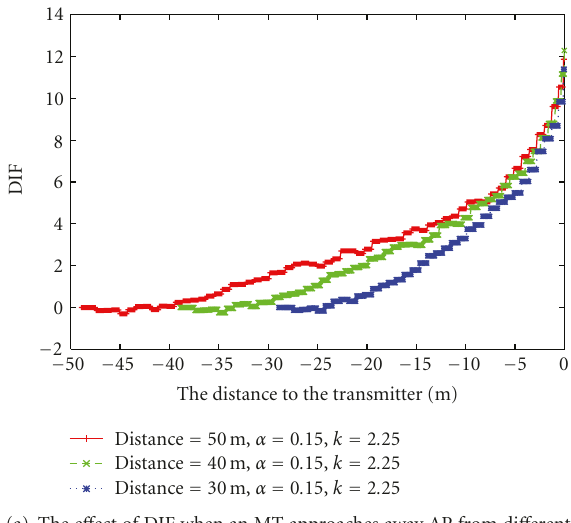
Figure 12: E ff ect of shadowing deviation in WLAN.